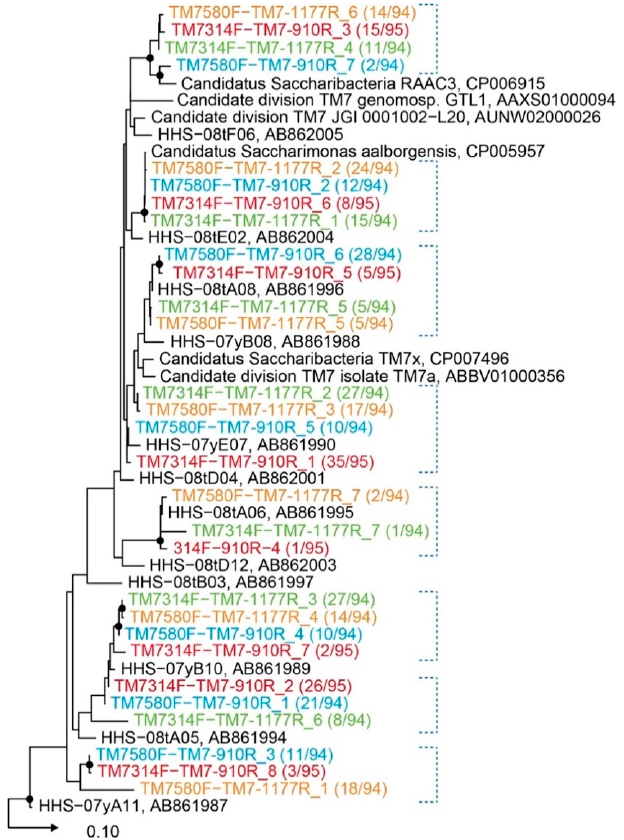
Figure 2. Maximum-likelihood phylogenetic tree of Saccharibacteria-related operational taxonomic units (OTUs) obtained from activated sludge. Colored OTUs represent OTUs obtained from different primer sets. Numbers in parentheses indicate the frequency of identical clones analyzed from each library. The scale bar represents the number of nucleotide changes on each position. Filled circles at the nodes represent bootstrap support of >90% obtained from 1000 resamplings. Blue dotted lines indicate identical clones detected with different primer sets. Five Thermotoga sequences were used as an outgroup. Black sequences labelled as HHS indicate OTUs obtained from a previous study [12]; other black sequences are reference sequences from the database.